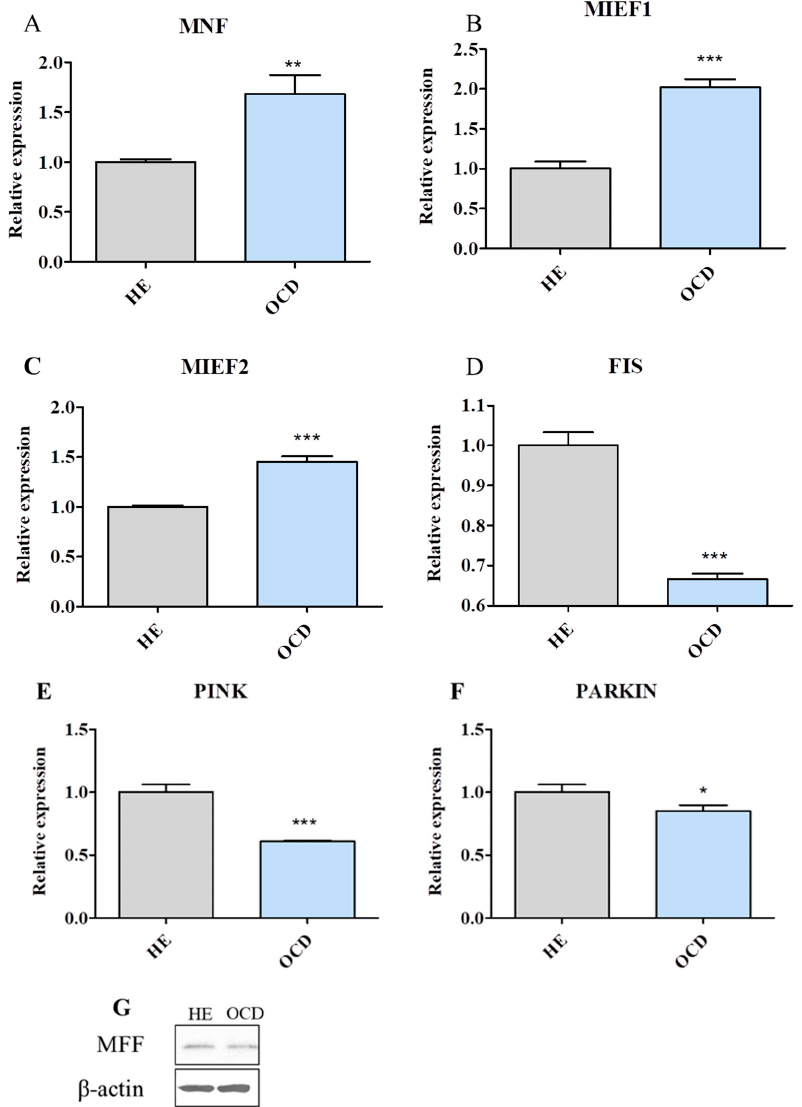
Figure 6. Assessment of mitochondrial dynamics and mitophagy. HE and OCD chondrocytes were analysed by RT-PCR for mRNA expression. Expression of MNF ( A ), MIEF1 ( B ) and MIEF2 ( C ) was established in order to compare intensity of mitochondrial fusion in investigated groups. To analyse mitochondrial fission, FIS expression was investigated ( D ). Moreover, expression of mitophagy markers: PINK ( E ) and PARKIN ( F ) was analysed. Mitochondrial fission factor (MFF) protein level was established by Western blot ( G ). Results expressed as mean ± S.D. * p < 0.05, ** p < 0.01, *** p < 0.001.